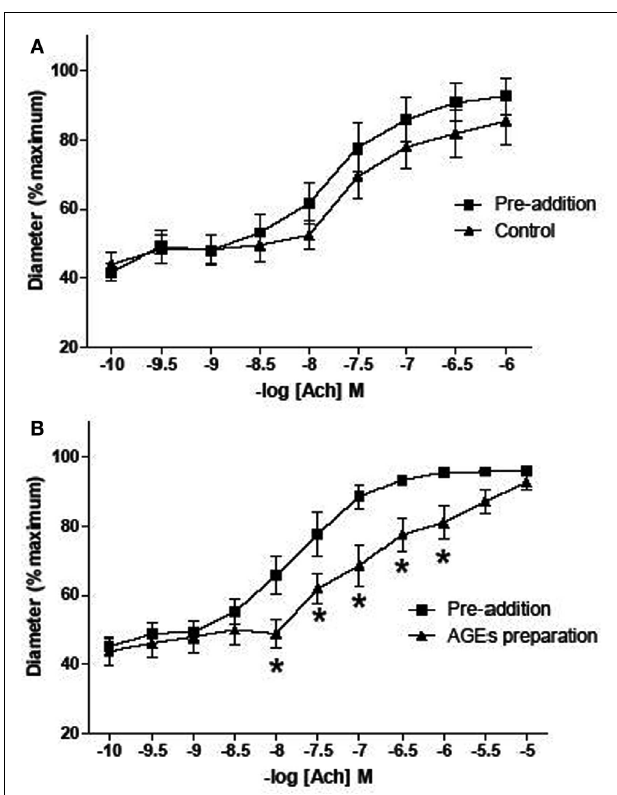
FIGUREA1 | Effect ofAGEs onACh-induced vasodilatation of arterioles from rat cremaster muscles. Arterioles were cannulated and